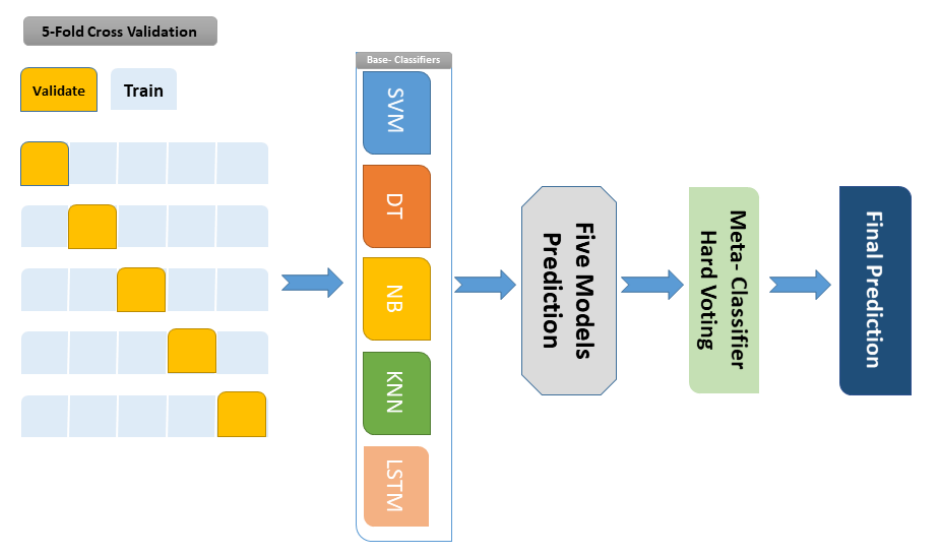
Figure 3. The 5-Fold cross